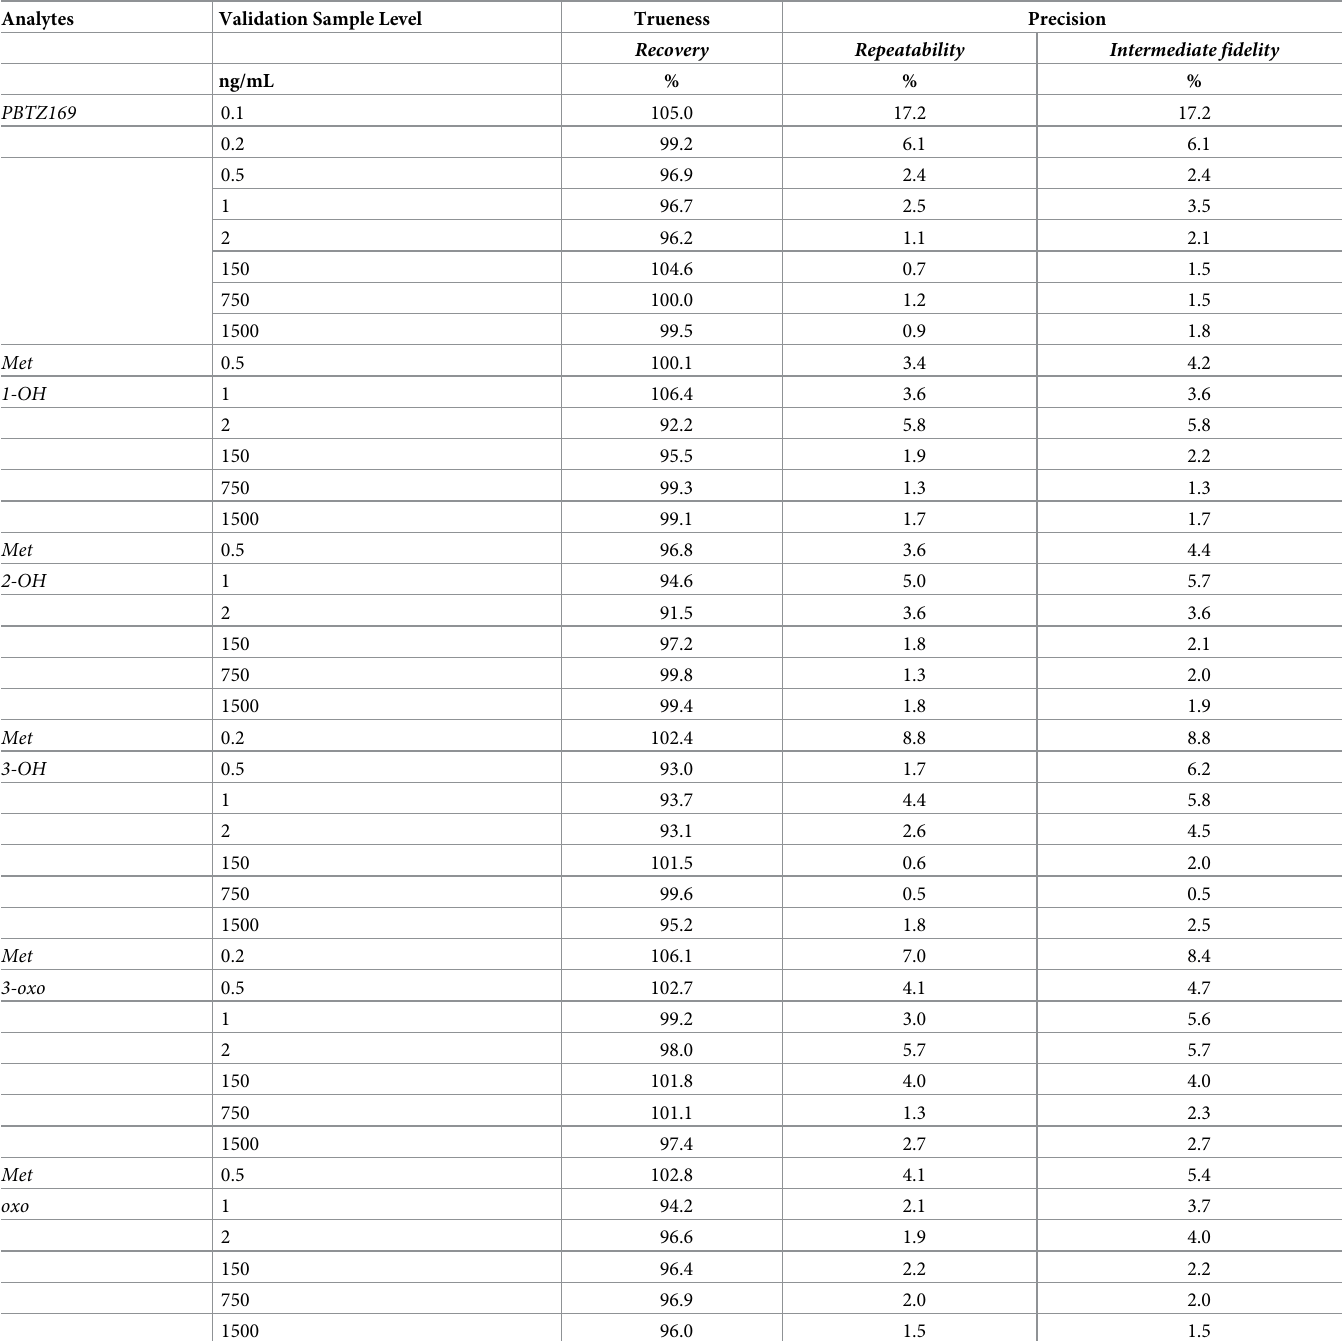
Table 2. Trueness, repeatability and intermediate precision determined in human plasma over the validated range for PBTZ169 and active metabolites. Analytes Validation Sample Level